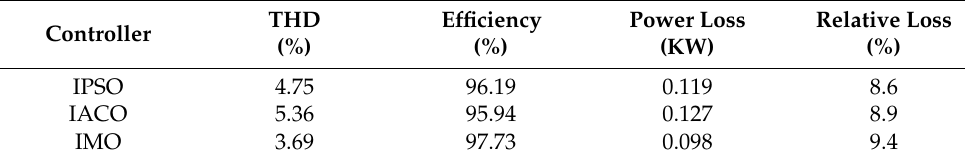
Table 2. Performance analysis of various controllers in terms of EV.